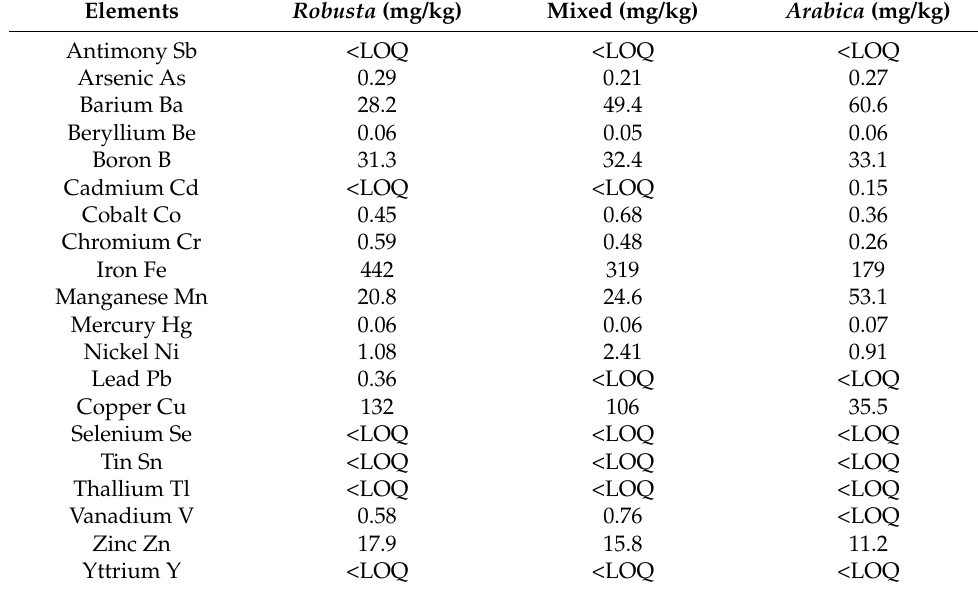
Table 1. Concentrations (mg/kg) of essential, toxic, and rare earth elements in three classes of samples ( n = 10) of coffee silverskin (CS). Results are expressed as mean ± standard deviation.